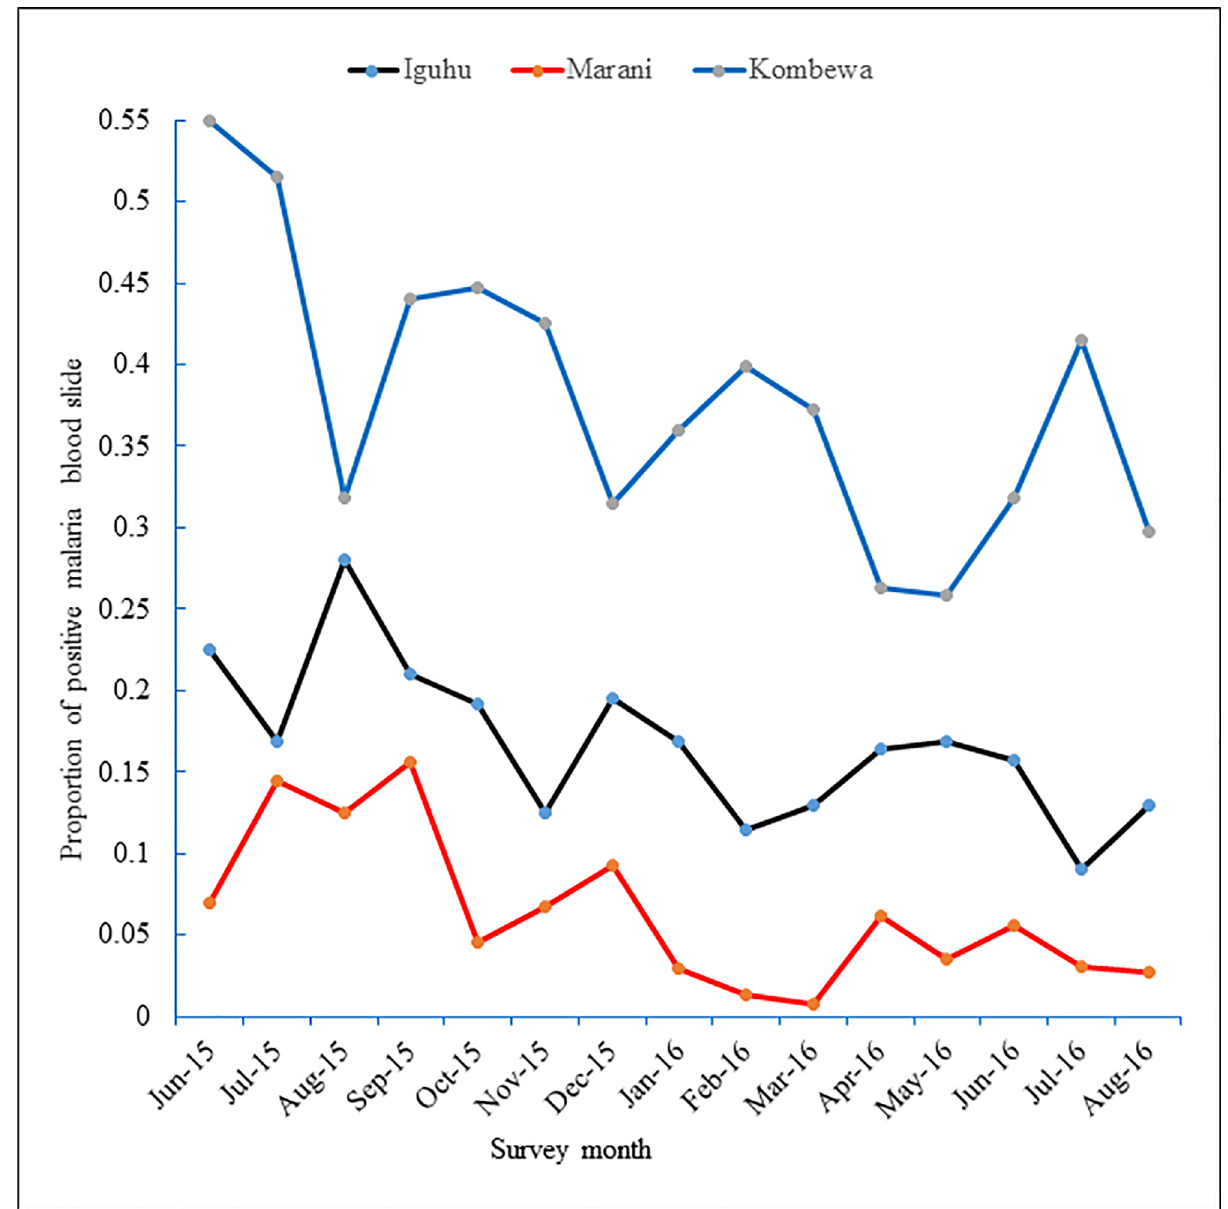
Fig 1. Dynamics of asymptomatic malaria parasitemia among primary school students in three study sites with different infection transmission intensity in Western Kenya from June 2015 to August 2016.